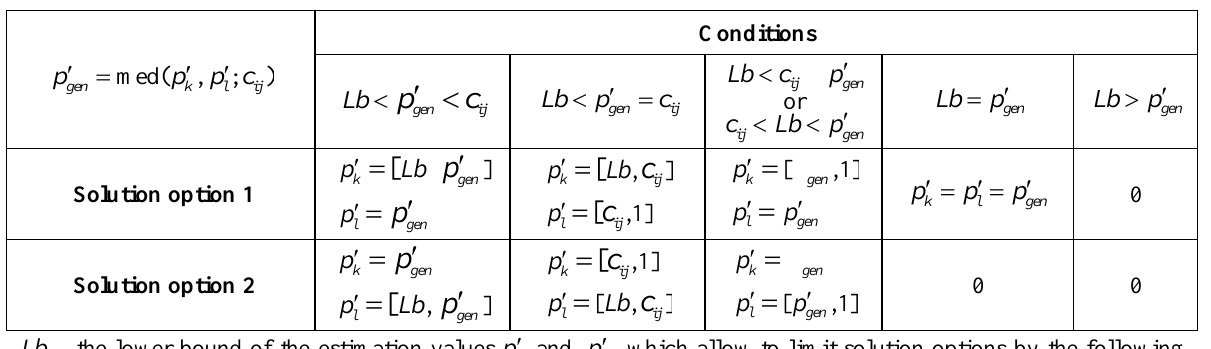
Table 11 – The rules for determining the values (ranges of values) of the arguments